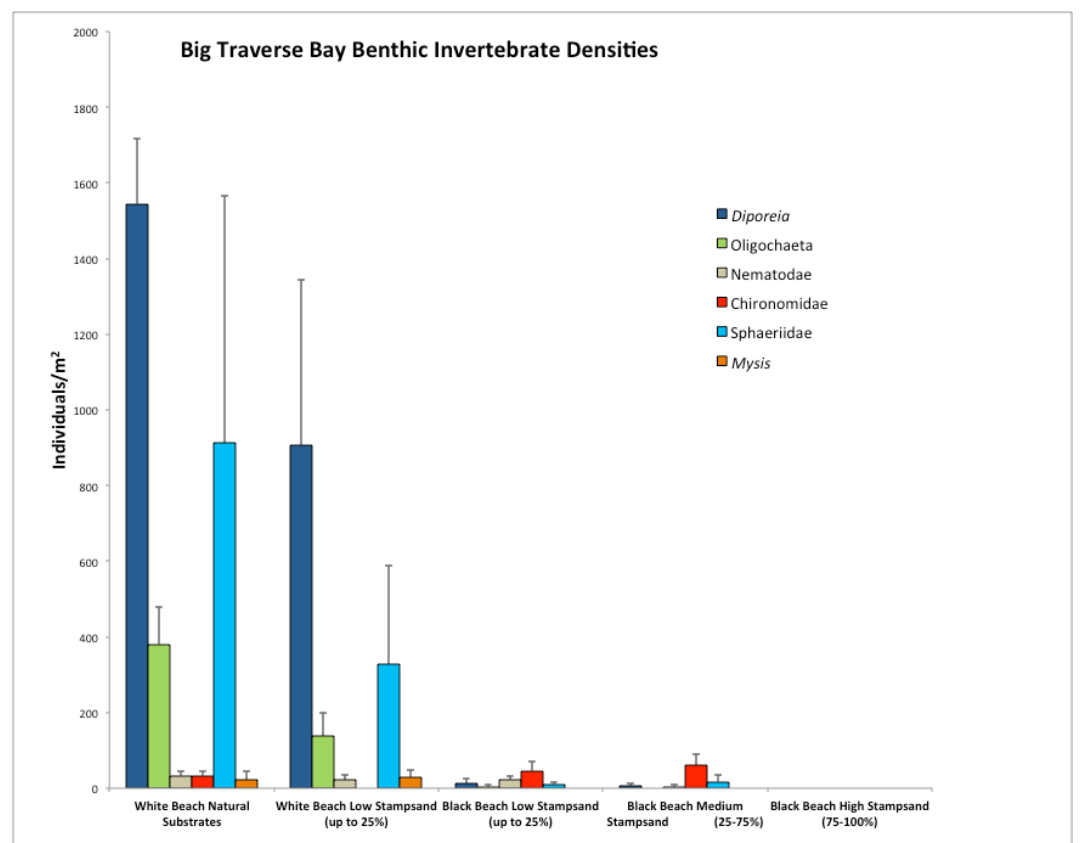
Figure 13. A major decrease in benthic organism density (Ponar samples) with an increase in stamp sand content (0% stamp sands, left panel; 0%–25% in the two middle left panels, 25%–75% in the middle right panel and 75%–100% on the far right panel). The bars give a mean density of ±95% C.L.; individual taxa are listed in the